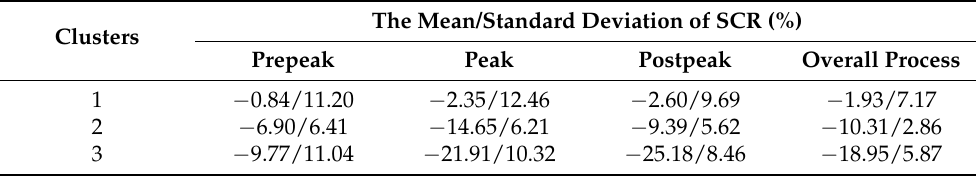
Table 3. The mean and standard deviation of the SCR of the links of three clusters. The Mean/Standard Deviation of SCR (%) Clusters Prepeak Peak Postpeak